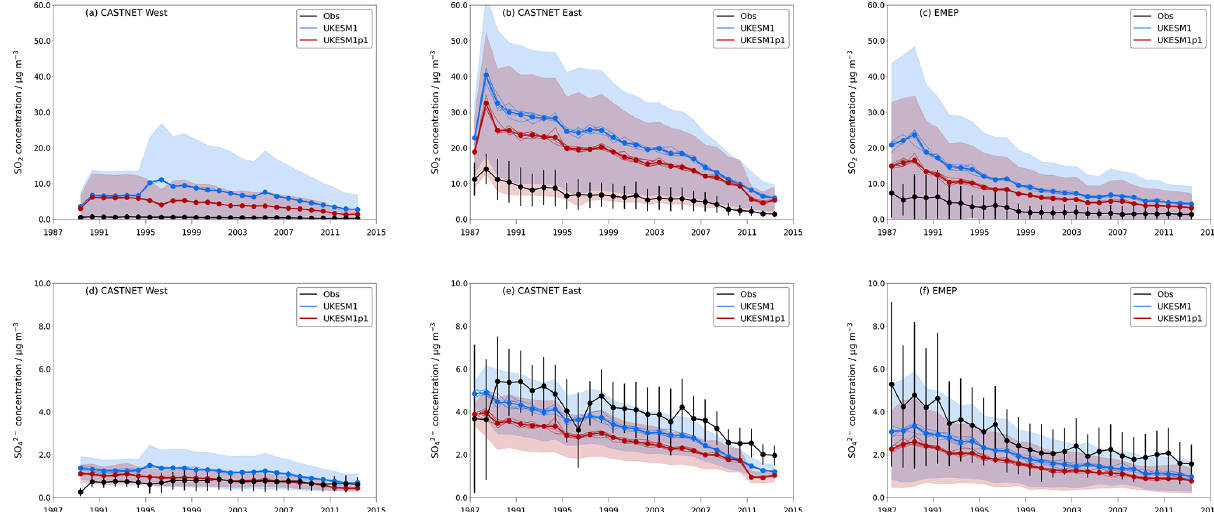
Figure 5. Comparison of annual mean (a–c) surface SO 2 concentration and (d–f) surface SO 4 aerosol concentration across a network of North American (Clean Air Status and Trends Network – CASTNET) and European (European Monitoring and Evaluation Programme – EMEP) measurement sites. CASTNET stations have been grouped into eastern and western sites as determined by their location east and west of 100 ◦